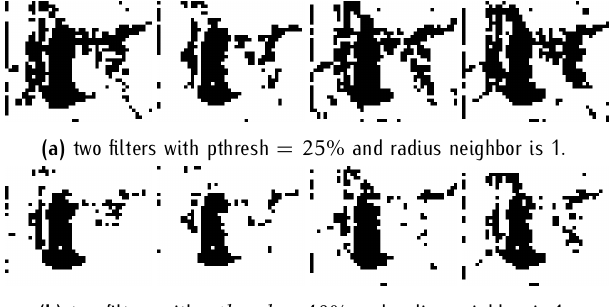
Figure 6. Zipfian Estimation with two proposed